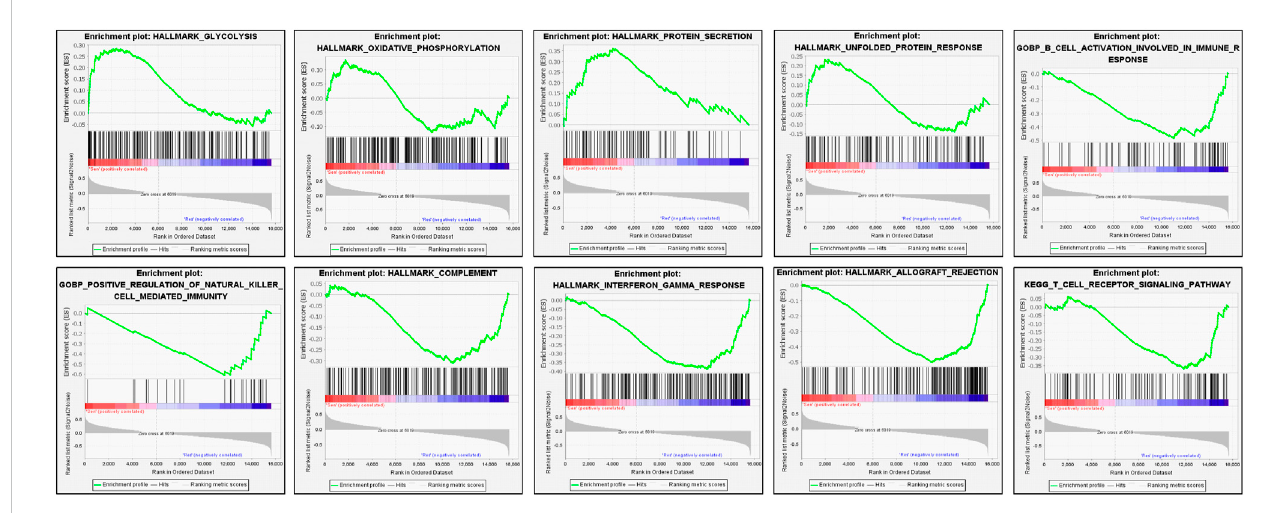
FIGURE 2 Enrichment plots derived from the gene set enrichment analysis (GSEA) related to drug-sensitive